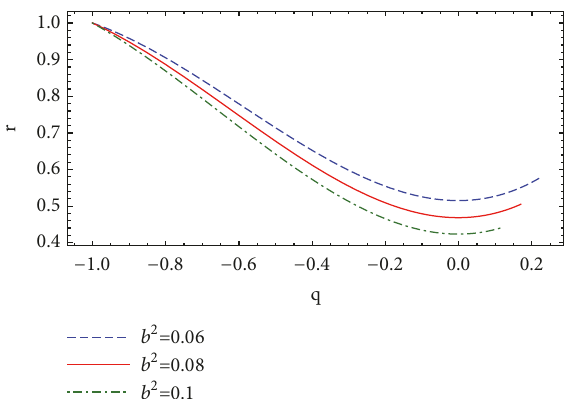
Figure 17: The evolution of the statefinder parameter 𝑟 versus the deceleration parameter 𝑞 for interacting GDE in the DGP model. Here, we have taken Ω 𝐷 (𝑧 = 0) = 0.73 , 𝐻(𝑧 = 0) = 67 , and Ω 𝑟 .0003.